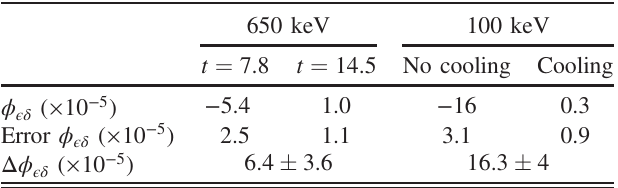
TABLE III. Extracted correlation coefficients for both horizon- tal measurements along both energy plateaus. The bottom row shows the absolute change between successive measurements.